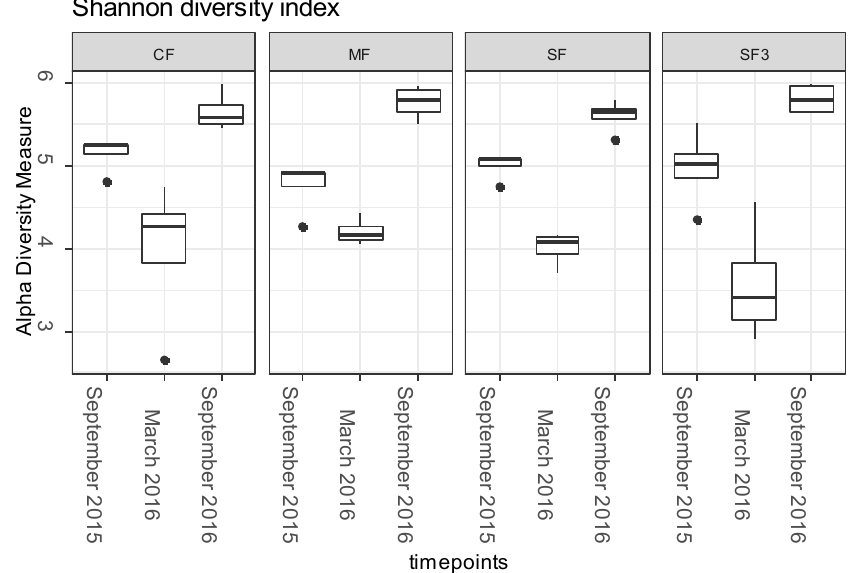
Figure 1. Shannon diversity index calculated from sequence data obtained from soils sampled at different time points. Fertilization treatments: control soil (CF), manure (MF; 330 kg N/ha), sewage sludge (SF; 330 kg N/ha), sewage sludge (SF3; 990 kg N/ha).